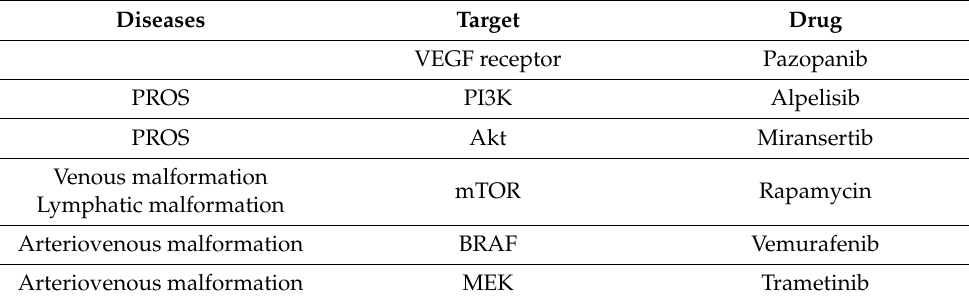
Table 2. Candidates of molecular targeting drugs for vascular anomalies.